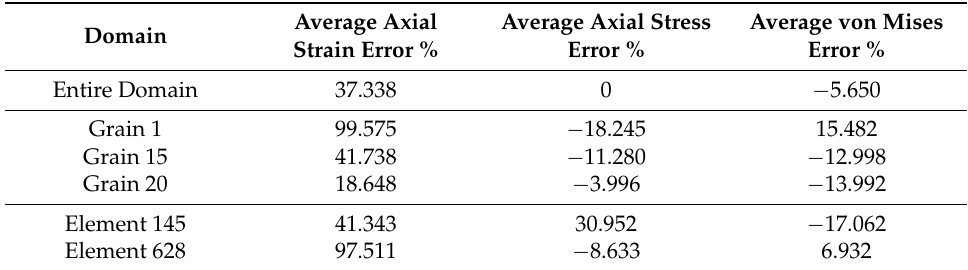
Table 3. Maximum percentile error of the GMC solution (compared to FEA) for the 3 ˆ 3 ˆ 3 polycrystal sample.